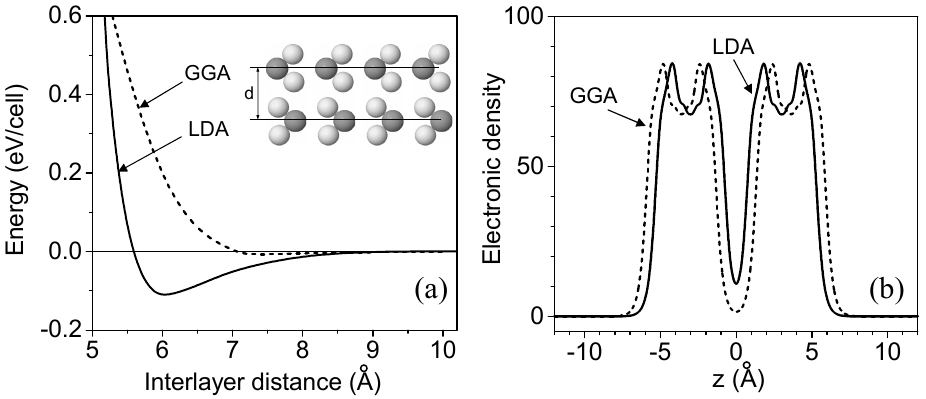
Figure 3. The dependence of the energy of interlayer interaction (per unit cell) for the MoS 2 bilayer on the distance between the layers ( a ) and the plane-averaged electronic density of the bilayer along the normal to the surface ( b ). LDA and GGA results are shown by solid and dashed lines, respectively.